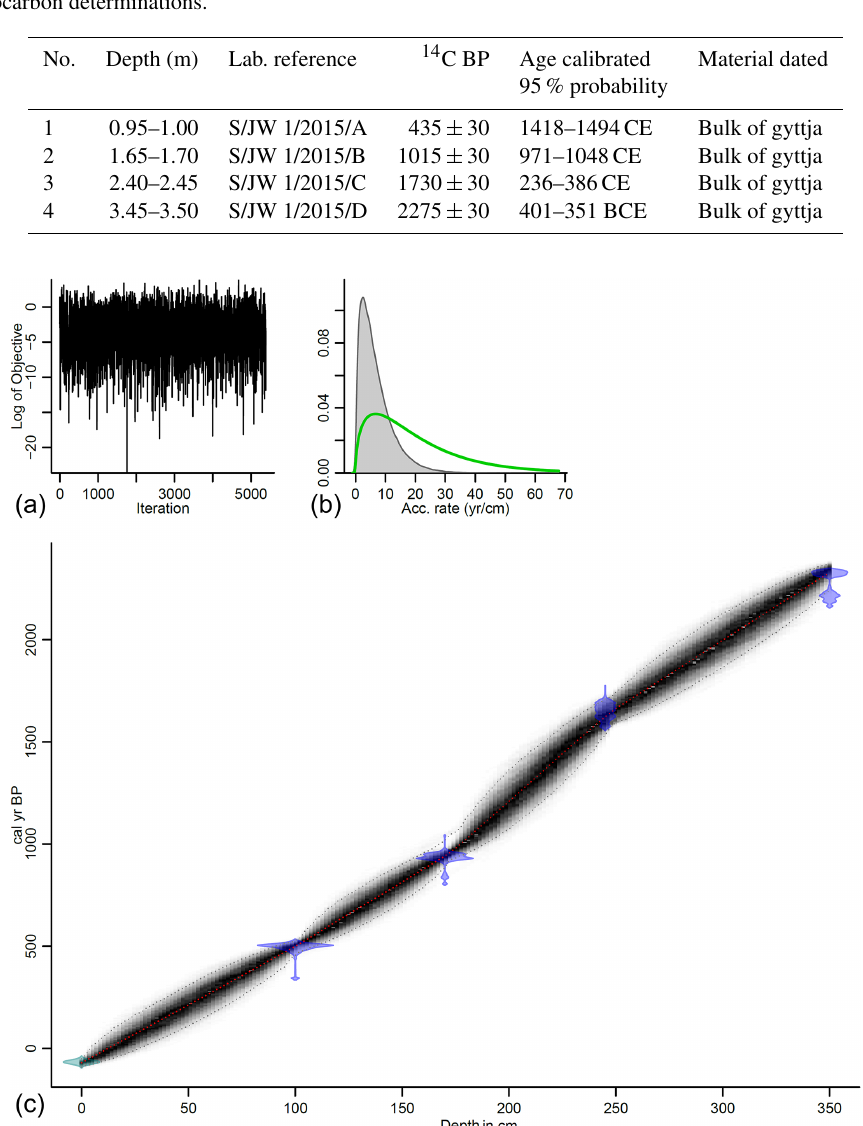
Figure 4. Age–depth model of the core M1 from the Lake Młynek sediments. Good runs of a stationary distribution are shown in panel (a) ; green curves and grey histograms in panel (b) present distributions for the sediment accumulation rate. Panel (c) shows the calibrated 14 C dates (transparent blue) and the age–depth model (darker grey areas), which indicate calendar ages. Grey stippled lines show 95% confidence intervals and the red curve shows the “best” model based on the weighted mean age for each depth. The model was created by Fabian Welc using the open Bacon software (Blaauw and Christen,